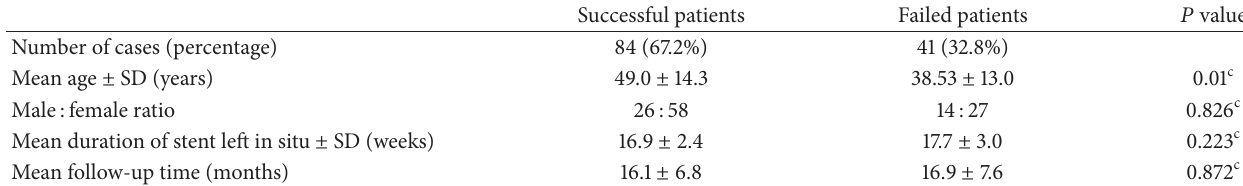
Table 2: Comparison of the success rate of the TCL-DCR in different age groups. Successful patients Failed patients 𝑃